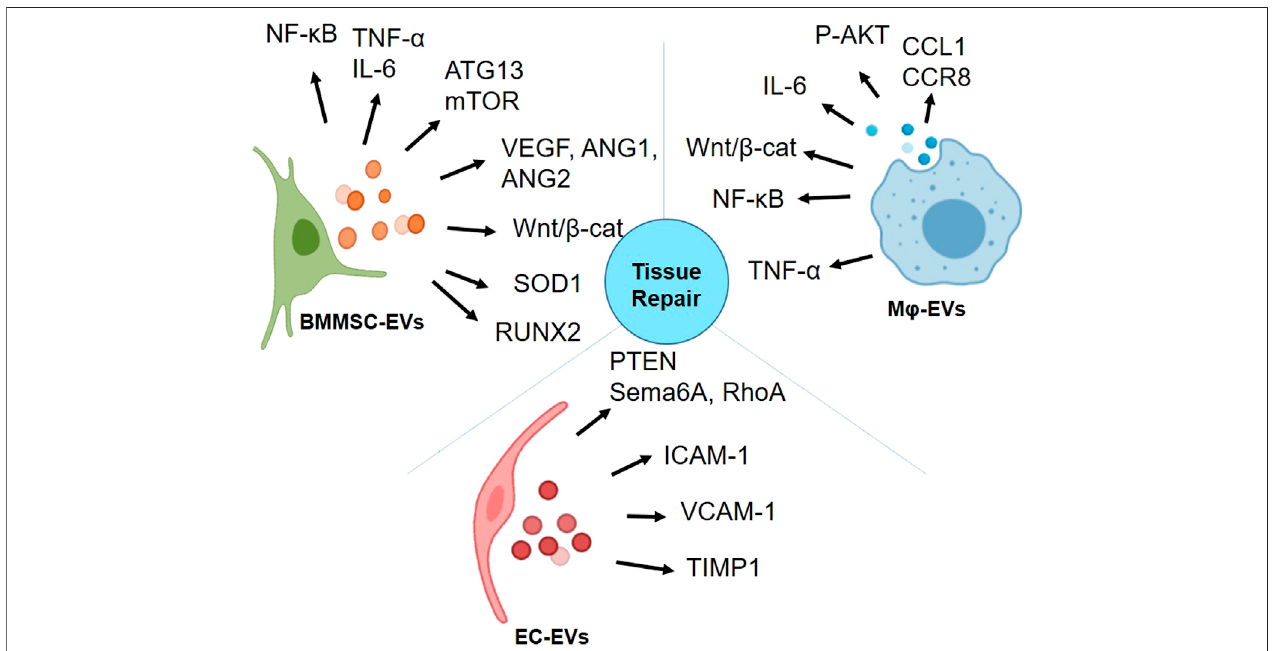
FIGURE 3 | Activation of proteins involved in various signaling pathways by bone marrow mesenchymal stromal/stem cell (BMMSC)-extracellular vesicles (EVs), endothelial cell (EC)-EVs, and macrophage (M ɸ )-EVs for tissue repair (Graphics adapted from BioRender.com).